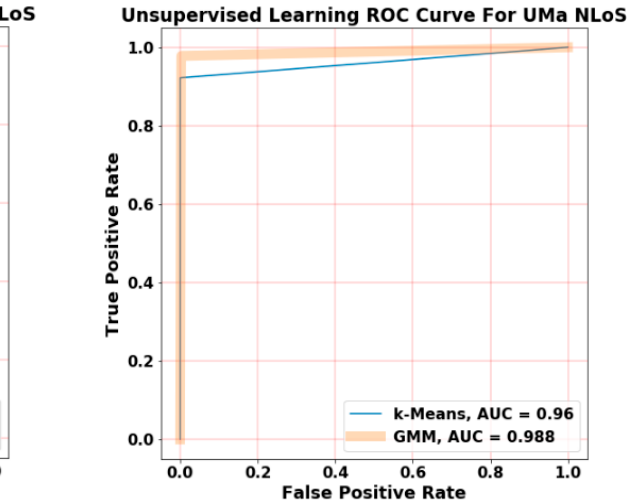
Figure 7. ROC and AUC scores for each scenario versus the others. Table 3. Time evaluation of each algorithm.